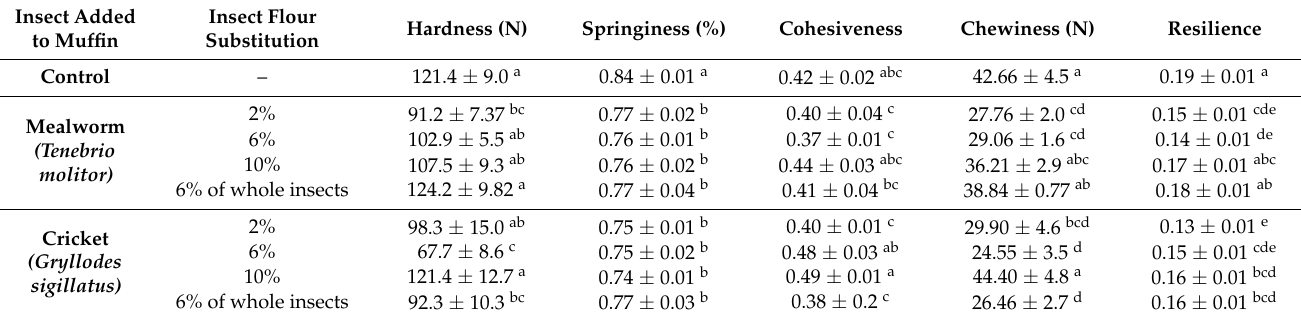
Table 3. Textural properties of